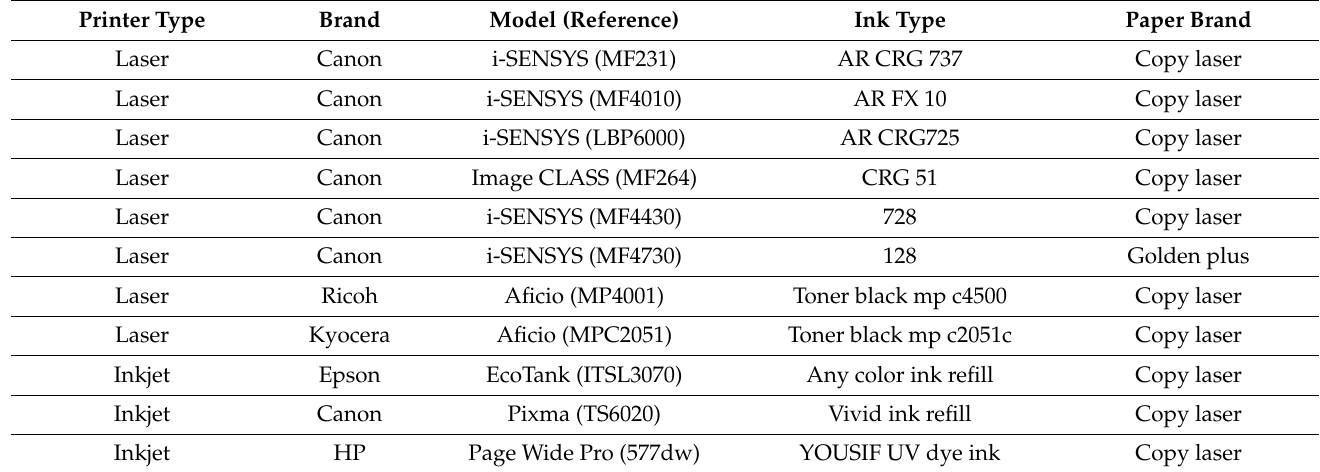
Table 1. Description of printed samples that represent printers’ references.